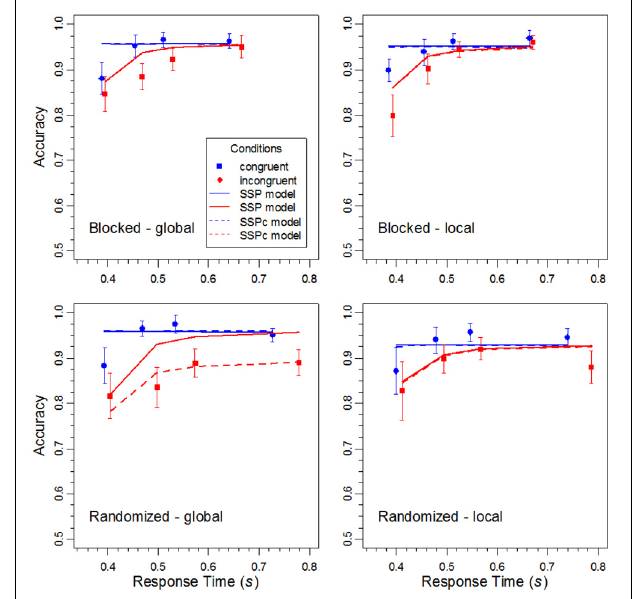
FIGURE 6 | The data points show the cumulative distribution functions for the RTs of correct responses for the different conditions in the experiment, and solid lines represent the corresponding performance of the SSP model. The error bars represent the 95%-confidence intervals of the theoretical functions, estimated from the results of the jackknife procedure. The dashed lines show the performance of the SSPc model (see Text for details).